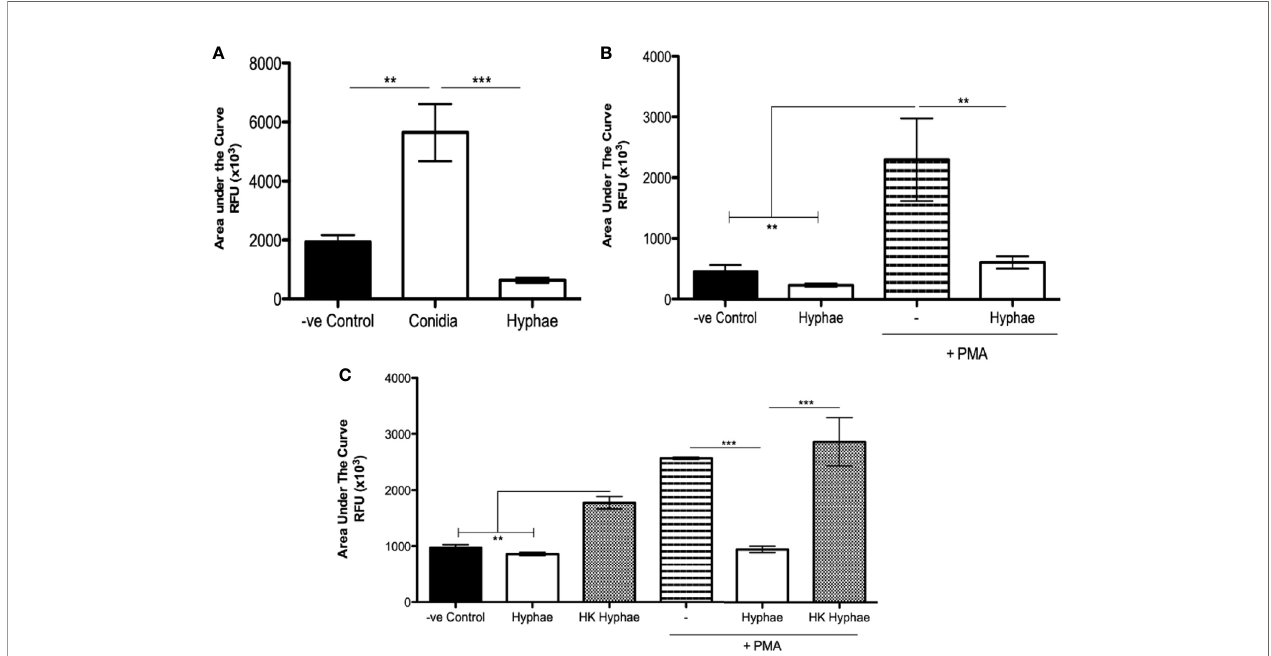
FIGURE 2 | Neutrophil ROS production is stimulated by F. pedrosoi conidia and blocked by F. pedrosoi hyphae. (A) WT neutrophils were puri fi ed using Ficoll density layer and then seeded in a 96-well plate in the presence of a luminol reagent and stimulated with F. pedrosoi conidia or hyphae. The ROS production was measured every 2 min to approximately 60 min. As unstimulated control, neutrophils were incubated in the absence of fungi to measure the ROS production during the steady state. The area under the curve was calculated to measure the total ROS production after 60 min. (B) To con fi rm that hyphae block ROS production, we stimulated the cells with PMA (highly stimulated ROS production) in the presence or absence of hyphae. (C) Using heated-killed (HK) hyphae, we demonstrate that live hyphae blocks while HK hyphae stimulates ROS production. Data are expressed as mean ± SEM; n =3, one-way ANOVA with Bonferroni ’ s posttest. ** p <0.01 *** p